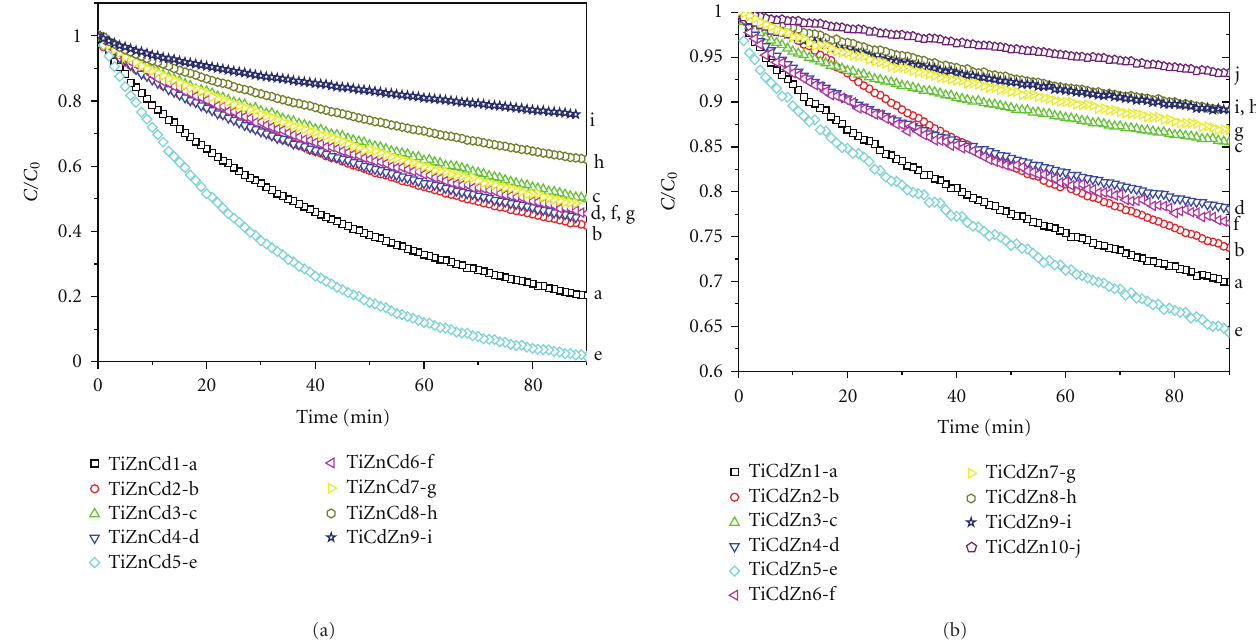
Figure 10: Orange II dye degradation on TiO 2 /ZnS/CdS nanocomposites at wavelength of (a) 365nm (b) over 400nm.